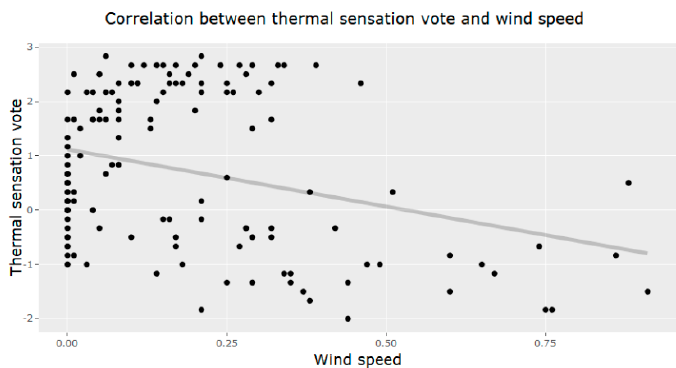
Figure 7. Correlation between the pedestrians’ thermal sensation votes and mean relative air humidity in the two analysis periods (January and July 2016).